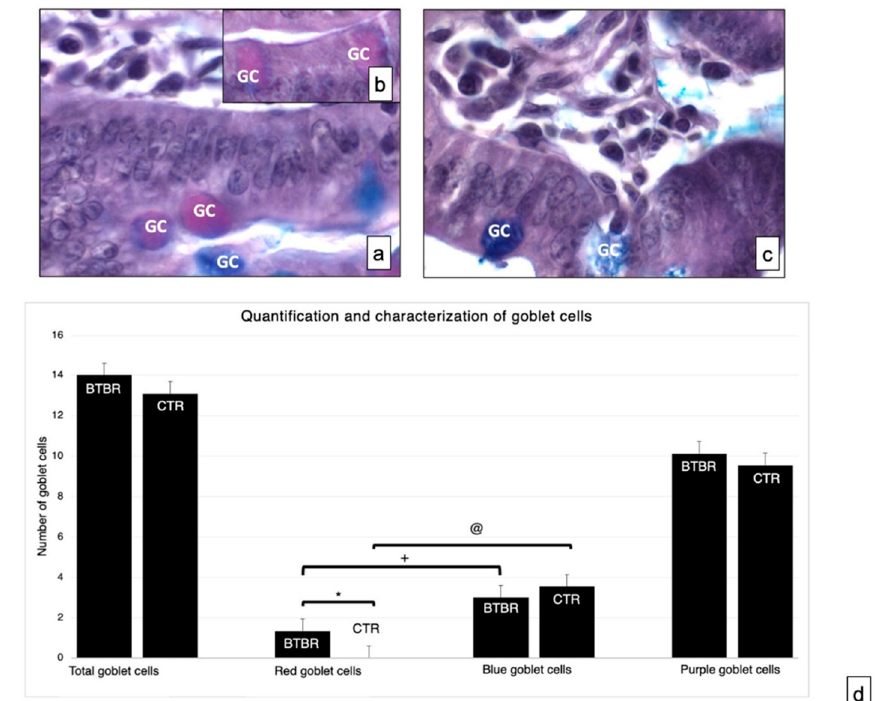
Figure 2. Representative histological images stained using PAS-Alcian Blue technique, which allows the identification of acid (blue) and neutral (red) and mixed (purple) carbohydrates. Goblet cells—GC. ( a , b )—BTBR mice; ( c )—CTR animals. ( a – c )—1000×; ( d )—quantification and characterization of goblet cells. Data are presented as mean ± SD. * p < 0.05 Red goblet cells, BTBR mice vs. CTR mice; + p < 0.05 red goblet cells vs. blue goblet cells in BTBR mice; @ p < 0.05 red goblet cells vs. blue goblet cells in CTR mice. The number of animals was 10 for BTBR and 10 for CTR; moreover, three samples for each animal were used. The images are a representative sample of all the tissues examined.